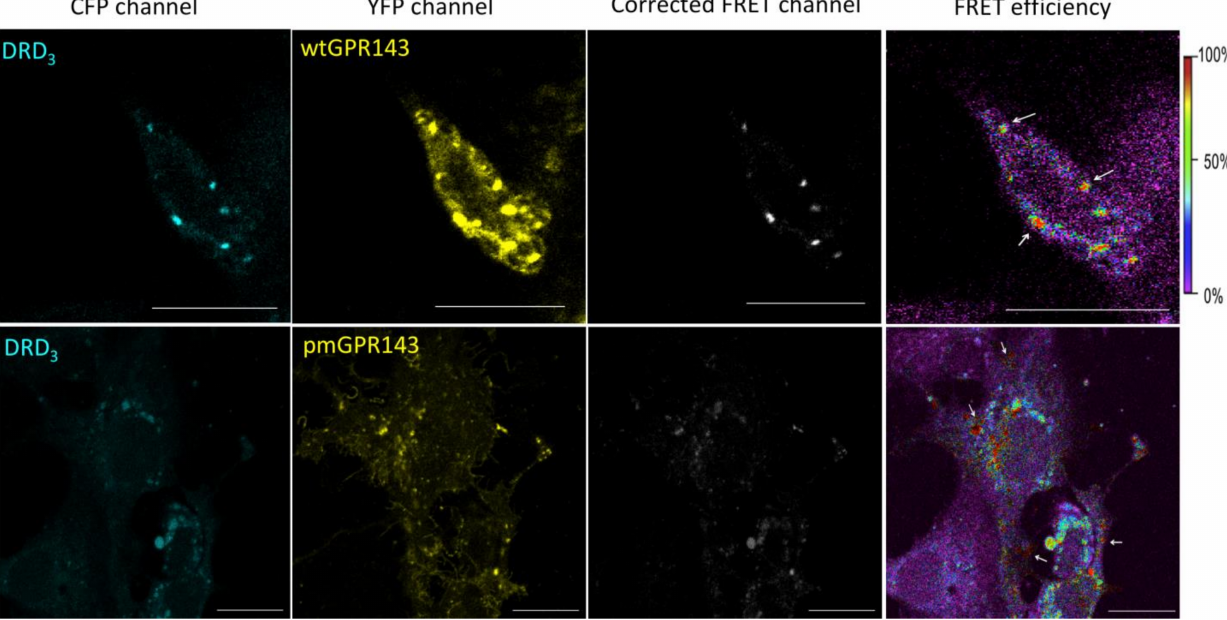
Figure 2. FRET of GPR143-YFP and DRD 3 -CFP in COS7 cells. A sensitized emission method was used to detect interaction between GPR143 (YFP channel) and DRD 3 (CFP channel). FRET signal, corrected by CoA and CoB parameters, and FRET efficiency (color scale on the far right) are shown. White arrows indicate regions where the FRET signal is localized. Controls are shown in Figure S2. Scale bar = 20 µ